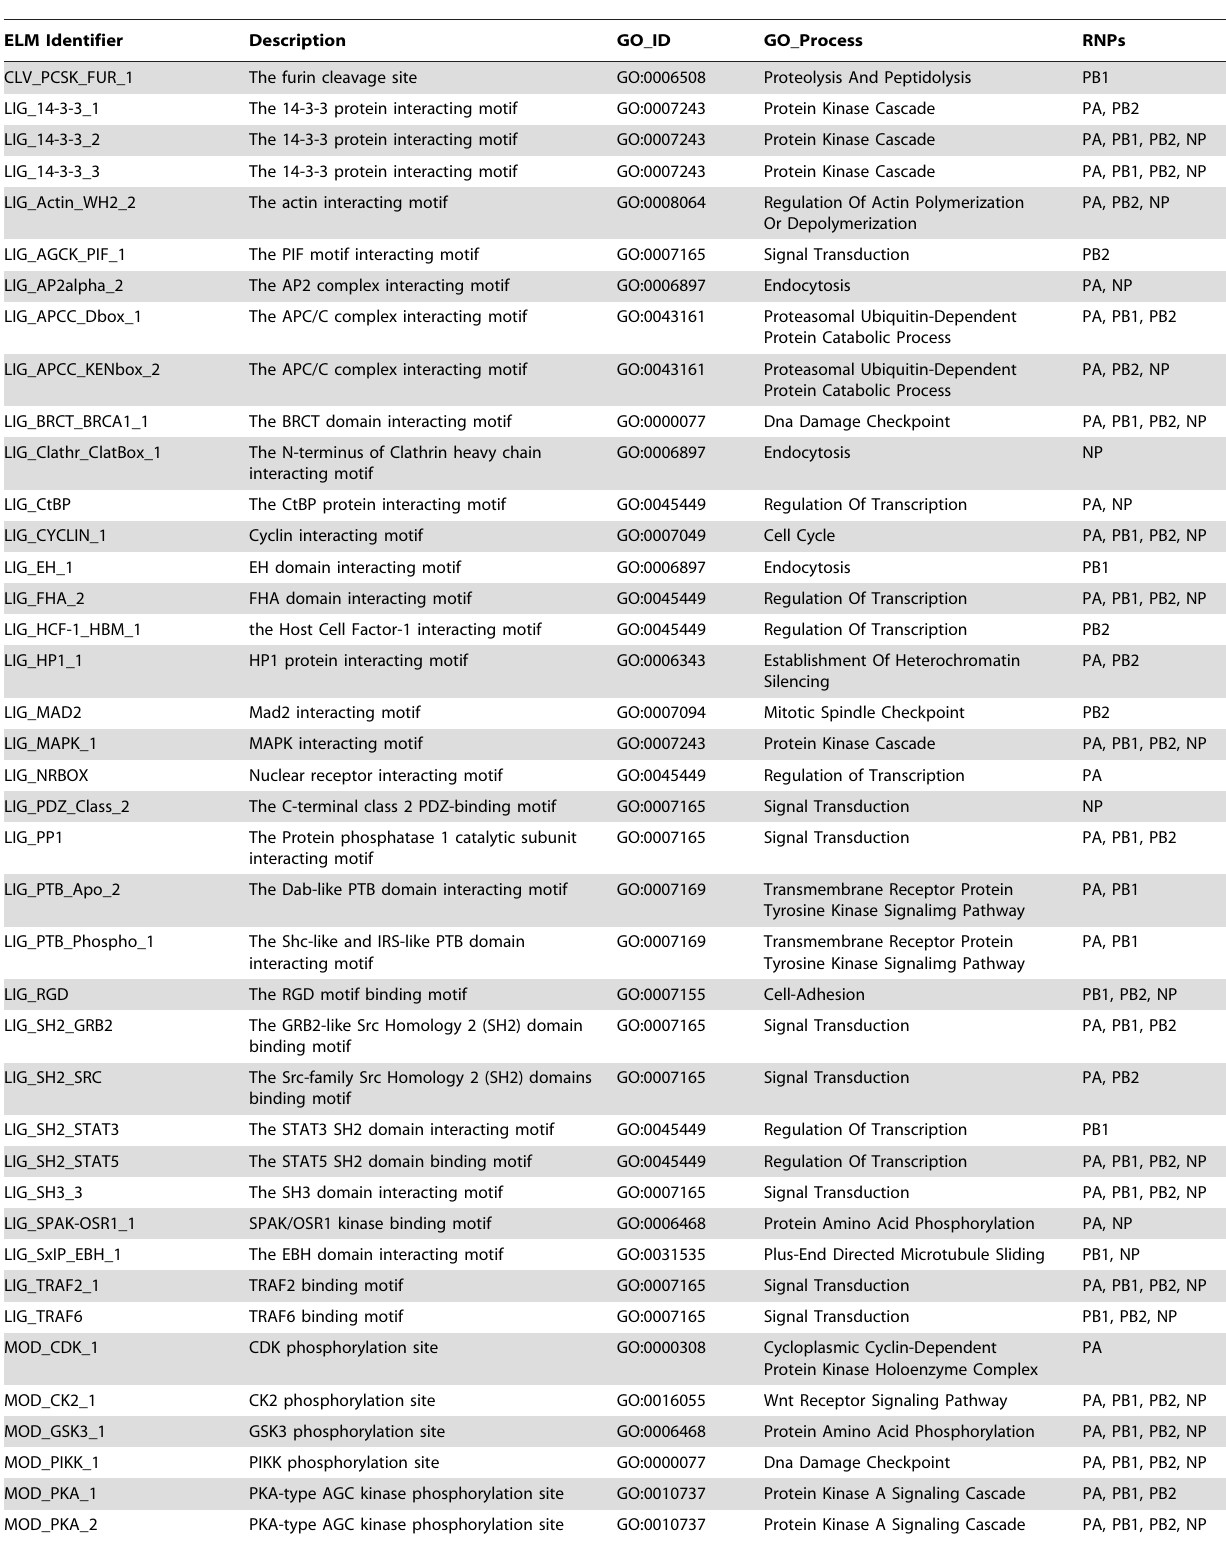
Table 6. Functions of SLiMs identified in IAV RNPs. In the ELM database [3], SLiMs are divided into four types: protease cleavage sites (prefix CLV), protein motif interacting/binding sites (prefix LIG), posttranslational modification sites (prefix MOD) and subcellular targeting signals (prefix